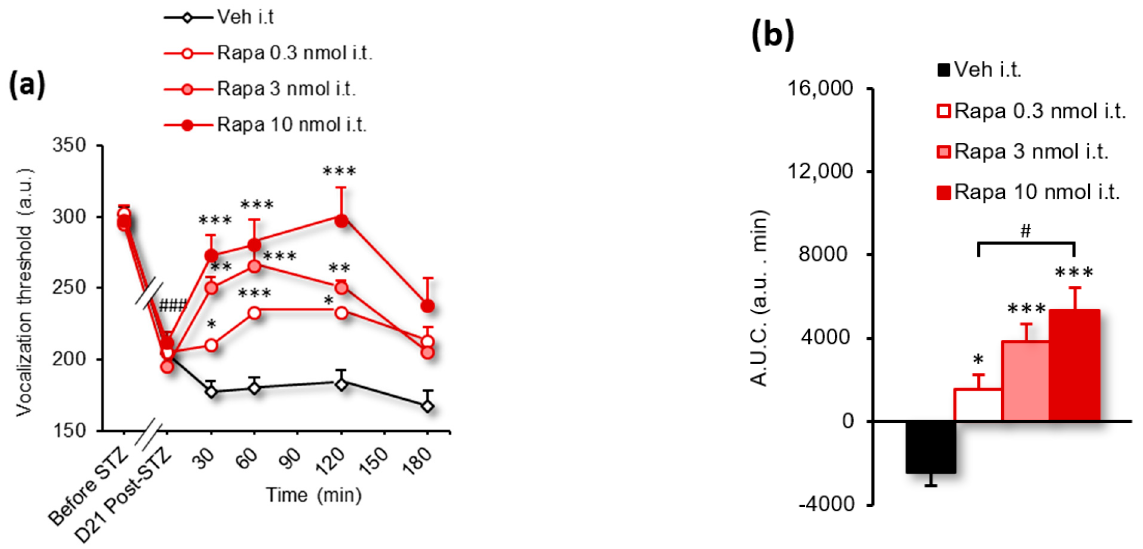
Figure 3. Intrathecal administration of rapamycin suppresses mechanical hyperalgesia (paw pressure test) in STZ diabetic rats. ( a ) Intrathecal administration of rapamycin (Rapa, 0.3–10 nmol/rat) but not the vehicle (Veh, water for injections) dose-dependently increases the vocalization threshold to paw pressure in STZ rats ( n = 6/group). ### p < 0.001 vs. values measured before STZ. * p < 0.05, ** p < 0.01, *** p < 0.001 vs. values measured before the drug/vehicle injection (D21 Post-STZ), 2-way ANOVA; ( b ) Area under the curve (A.U.C.) of vocalization threshold variations in STZ rats calculated by the trapezoidal rule (in a.u. min). * p < 0.05, *** p < 0.001, vs. Vehicle group; # p < 0.05 vs. corresponding group, 1-way ANOVA.